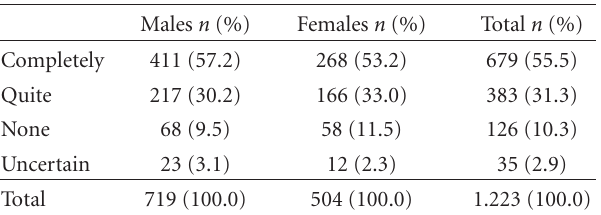
Table 6: Overall patients’